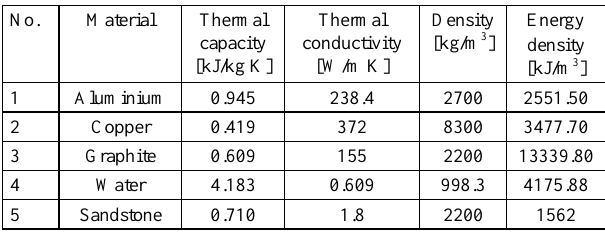
Table 1. Sensible heat storage materials and their thermal properties in 20°C [3]